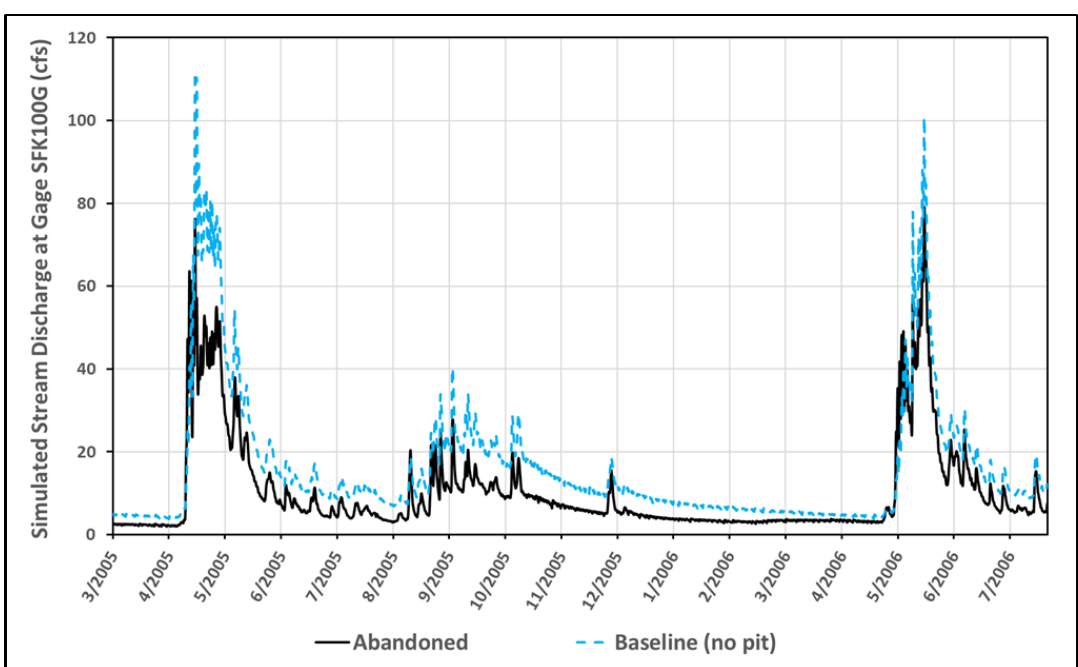
Figure 9. Simulated stream discharge at gage SK100G (cfs) in the upper South Fork Koktuli River (see Figure 1) for baseline (no pit) and abandoned conditions. Hourly weather data from the dates shown were used to predict post-closure conditions.